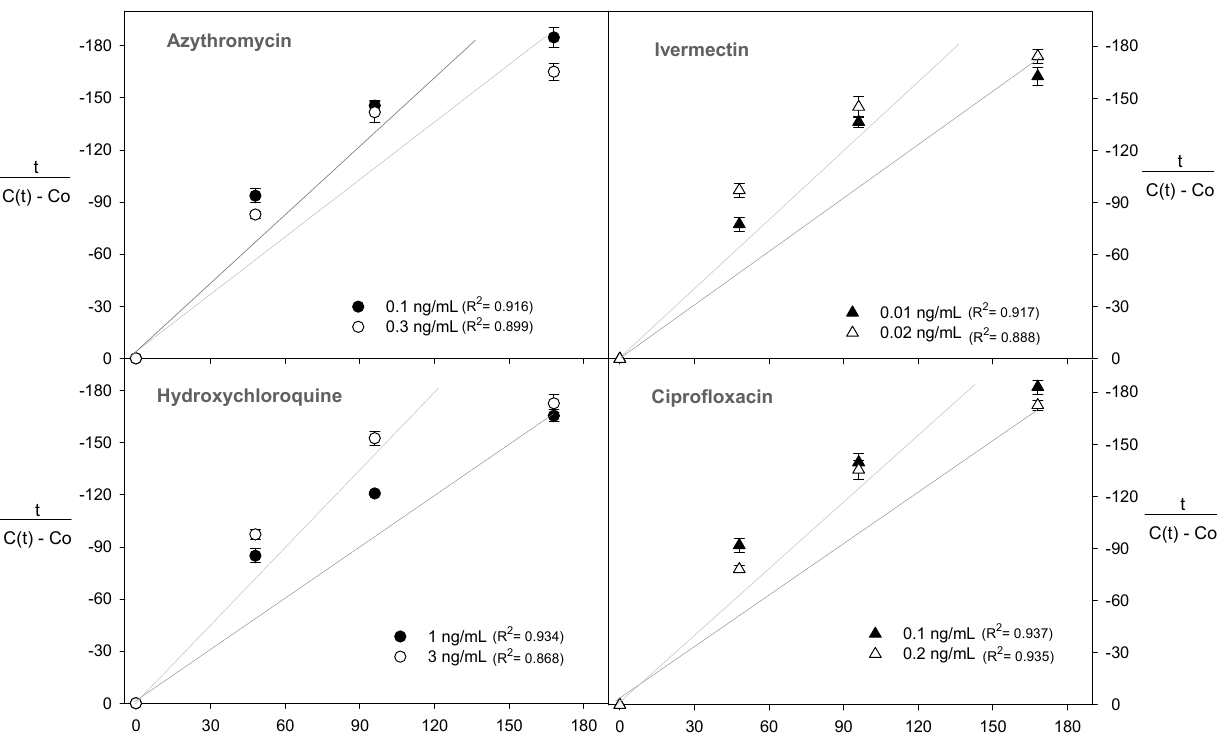
Figure 4. Peleg’s model linearisation of the total polyphenol content, where t corresponds with the time (min), C(t) is the concentration of polyphenols at time t, and C 0 is the concentration of polyphenols at zero time.